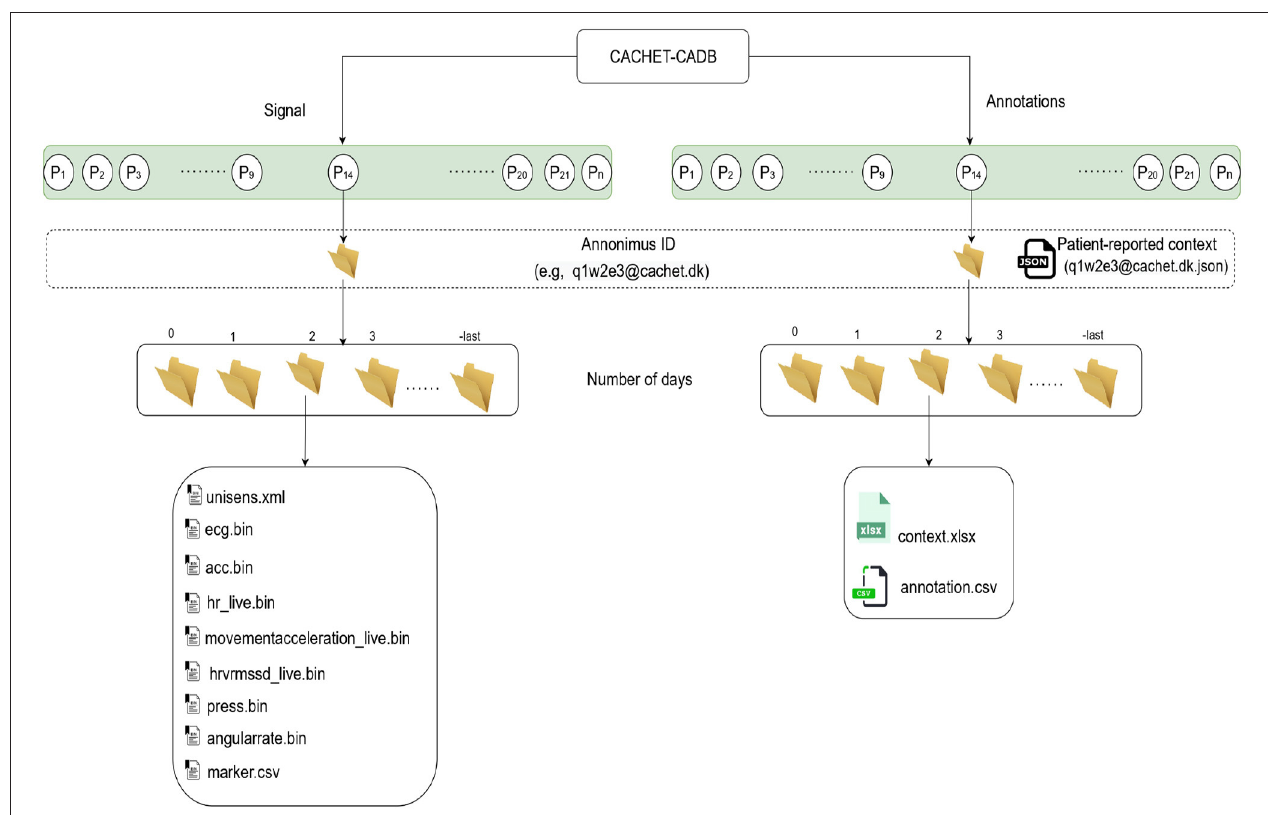
FIGURE 5 | The structure of the data records in CACHET-CADB. Overall, the database is divided into two major parts; (i) the raw recordings in binary files and (ii) the contextual information including patient-reported data and the annotations. Each record is organized according to patient ID first and day in study